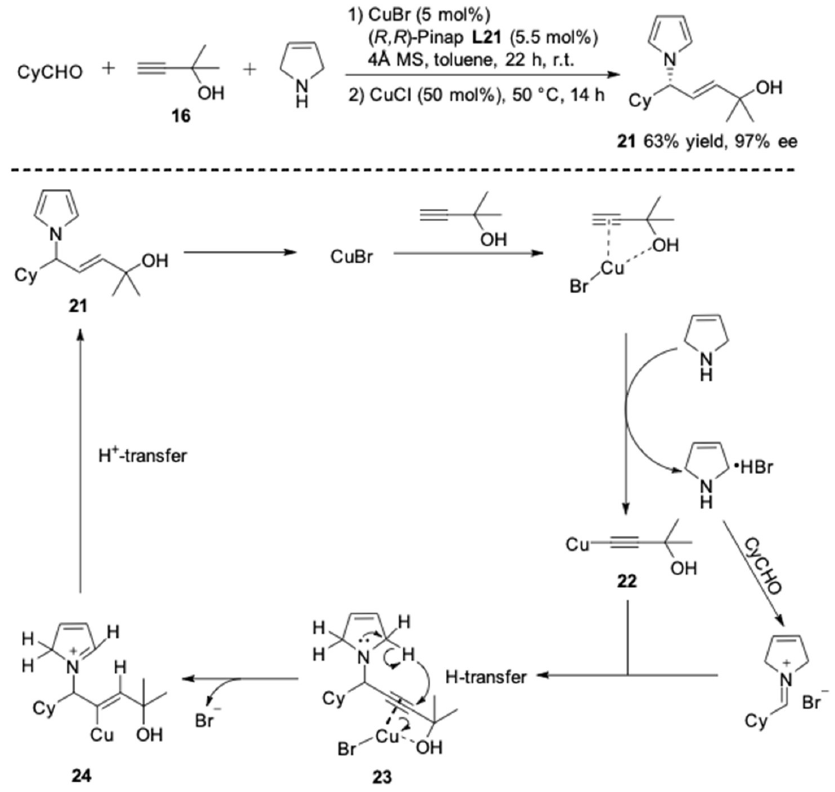
Figure 21. The synthesis of N -allyl amines via A 3 -couplings.